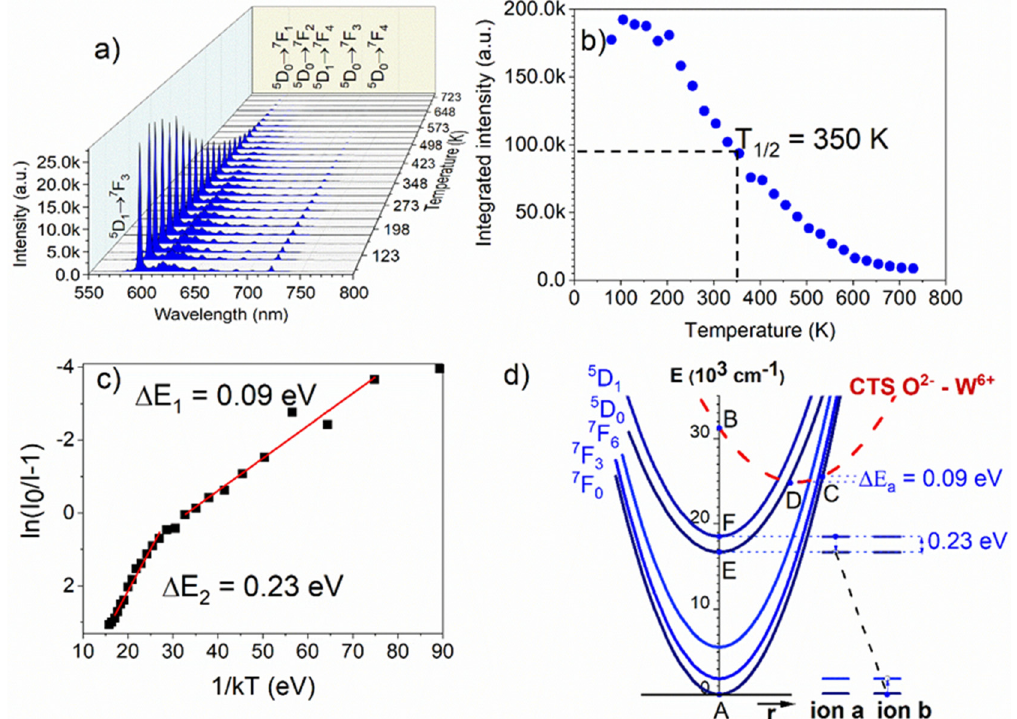
Figure 10. ( a ) The emission spectra of Ba 2 MgWO 6 : 5% Eu 3 + measured as a function of temperature; Figure 10. a ) The emission spectra of Ba 2 MgWO 6 : 5% Eu 3+ measured as a function of temperature; b ) ( b ) The integrated intensity as a function of temperature; ( c ) Activated energies ( ∆ E a ) of two processes The integrated intensity as a function of temperature; c ) Activated energies ( ∆ E a ) of two processes calculated from a function of ln(I 0 / I-1) versus 1 / kT; ( d ) Simplified single configurational coordinate calculated from a function of ln(I 0 /I-1) versus 1/kT; d ) Simplified single configurational coordinate energy diagram of Ba 2 MgWO 6 : Eu 3 + energy diagram of Ba 2 MgWO 6 : Eu 3+ .